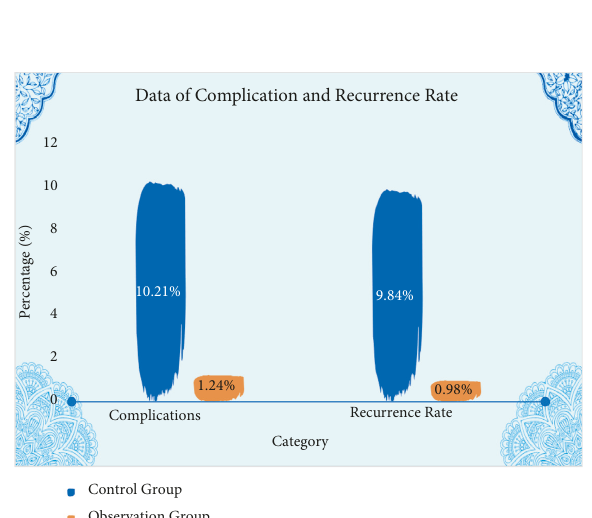
Figure 4: Comparison of Lysholm scores.